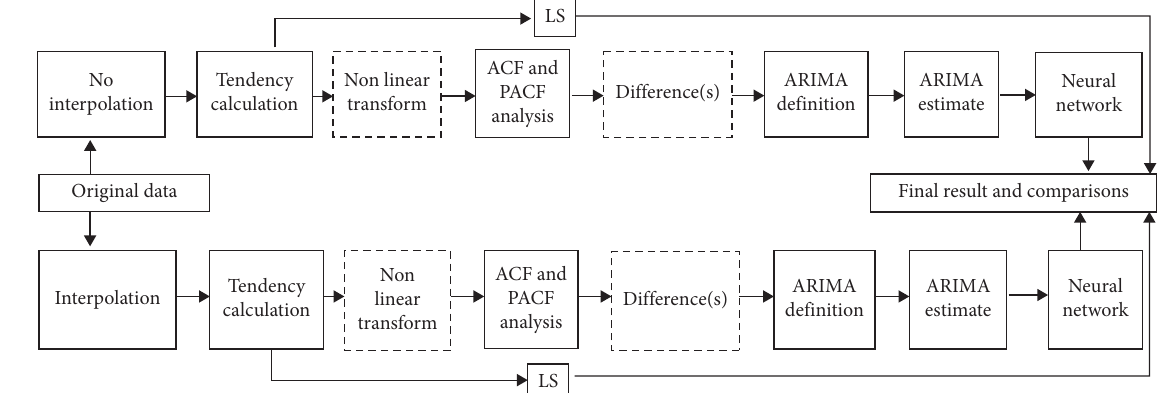
Figure 4: All steps in the fitting